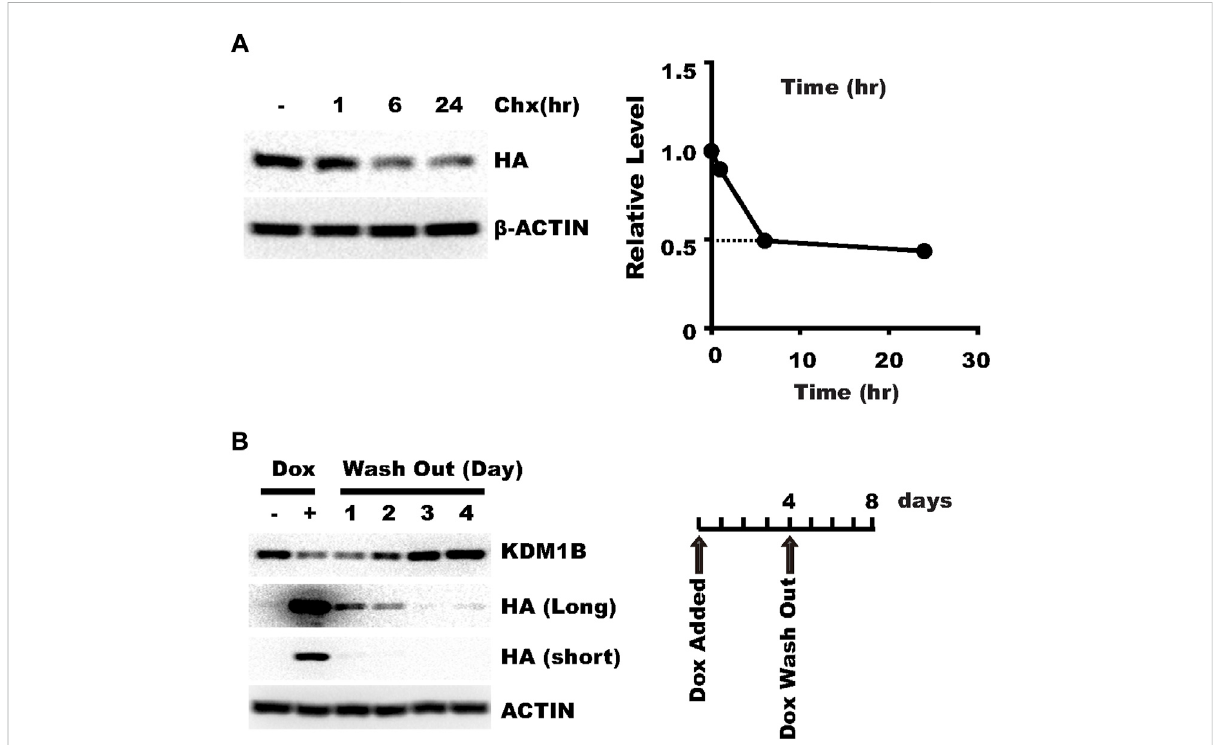
pLenti-TRE-CasRx-U6-gRNA can achieve reversible knockdown. (A) HLF cells transduced with a virus expressing pLenti-TRE-CasRx-scram wereselectedwith1 μ g/mlpuromycinfor5 daysandthentreatedwith25 μ g/mlcycloheximidefortheindicatedtime.ShownareWBresults. (B)